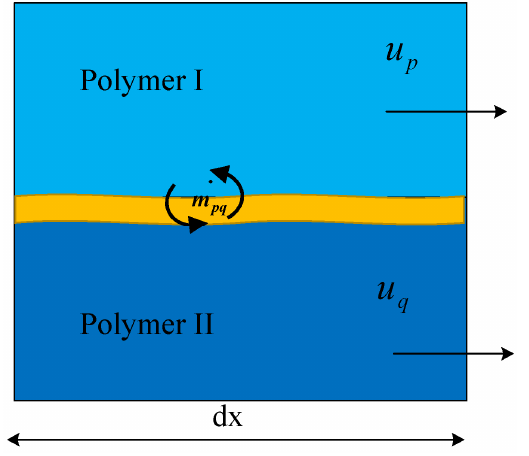
Figure 4. Schematic diagram of two-phase slip.